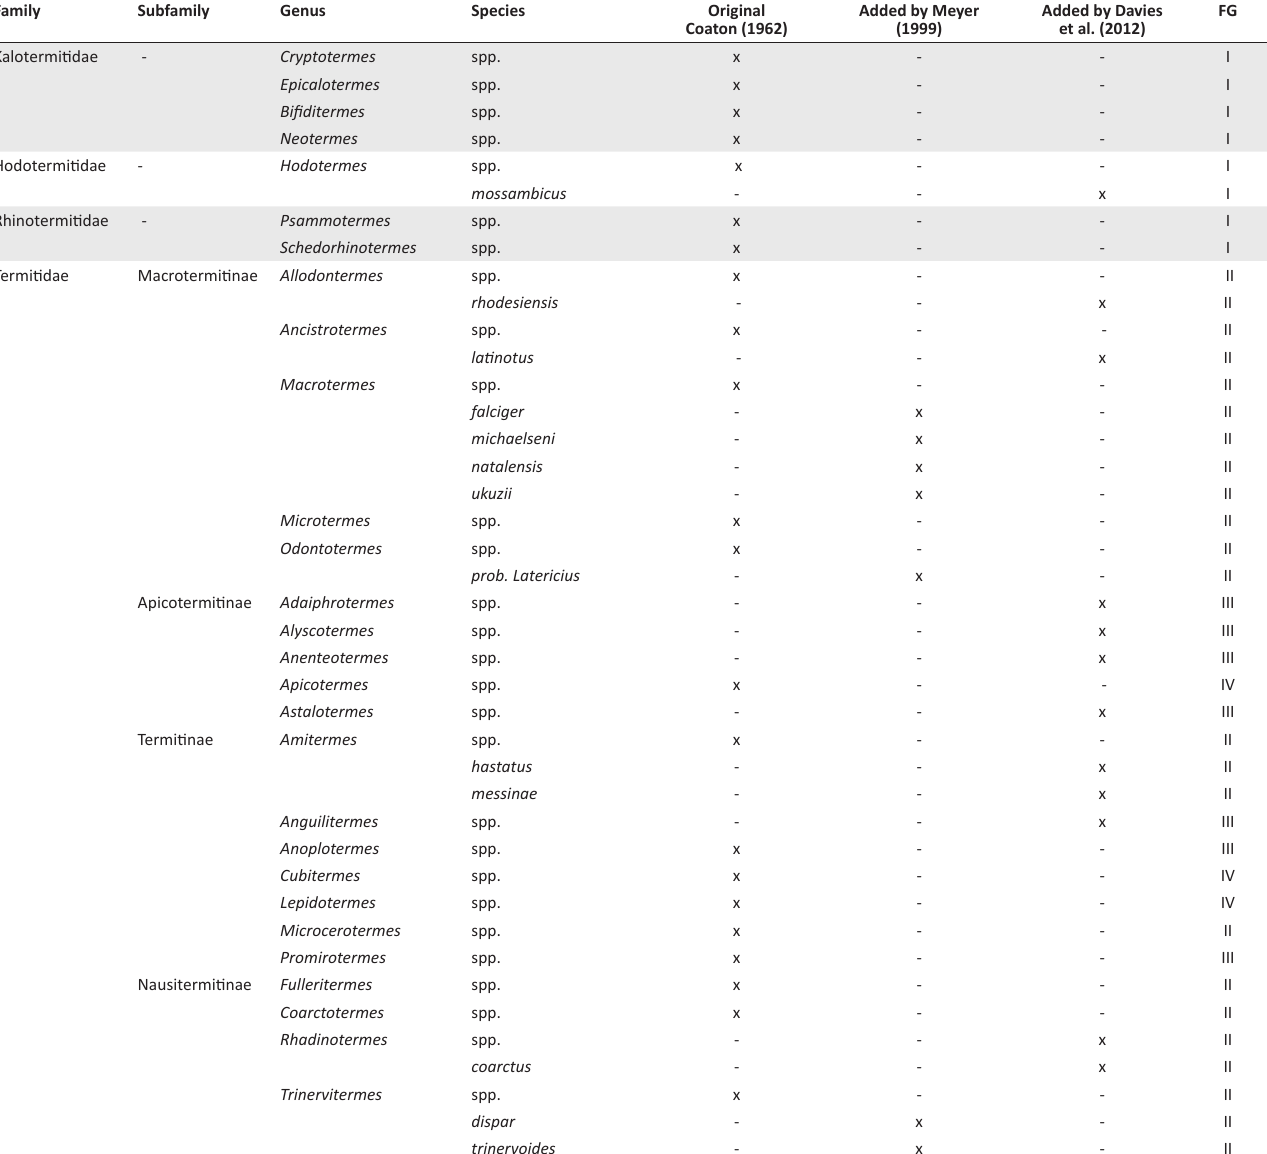
TABLE 2: Checklist of termites known to occur in the Kruger National Park, South Africa. Family Subfamily